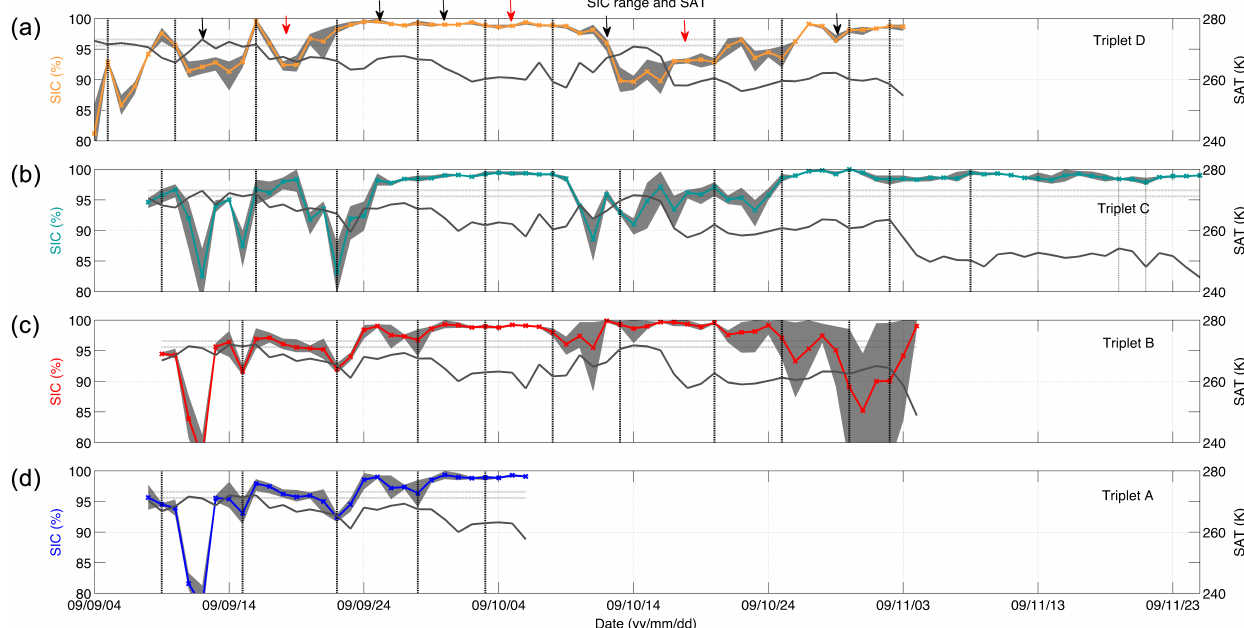
Figure 7. Sea ice concentration (SIC) range and surface air temperatures (SAT). Time series of percent sea ice concentration and SAT for triplets A (d) to D (a) . Vertical lines depict dates associated with SLP highs. Grey shading shows the range of ice concentrations encountered by three beacons comprising the triplets. Horizontal lines depict SAT values of 273 and 275K. SAT values less than 2 ◦ C are sustained following 14 September 2009 for triplets A to D, with an interval of increased SAT near 14 October. SIC varies for triplets A to D, with lower concentrations to 24 September. Low SIC exists during a SLP high for triplet C near 22 September. Lower SICs are observed following the 8 October SLP high, indicating deterioration in the sea ice